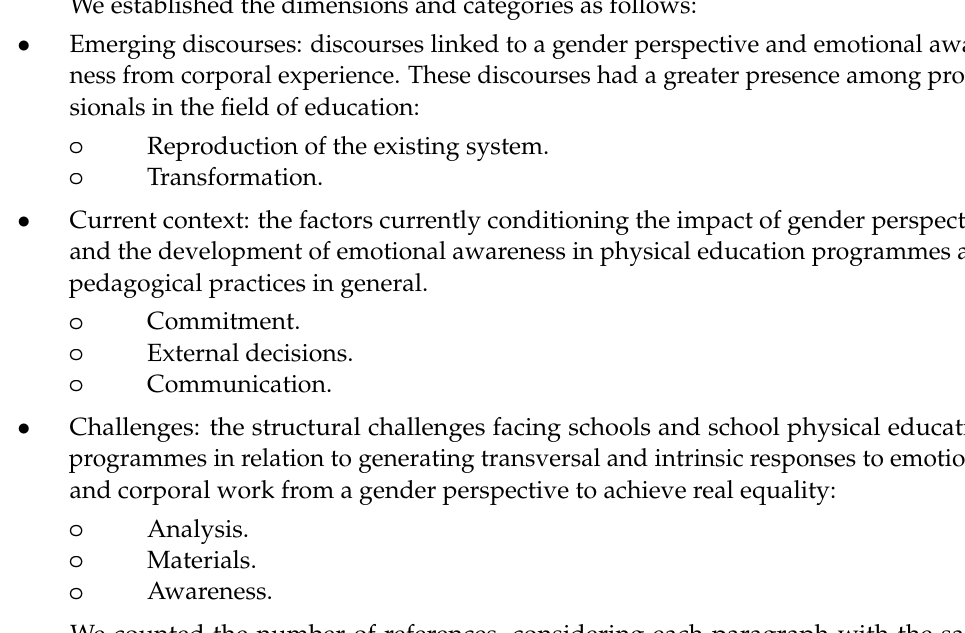
Figure 1. General process of qualitative data analysis. Adapted by the authors [68].